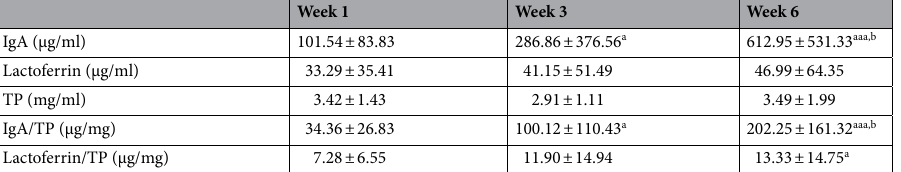
Table 3. Changes in immunity-related proteins in saliva during 6 weeks of HT activity. Data are expressed as mean ± SD. TP, total protein expressed as bovine serum albumin level. a p < 0.05, aaa p < 0.001 compared to Week 1. b p < 0.05 compared to Week